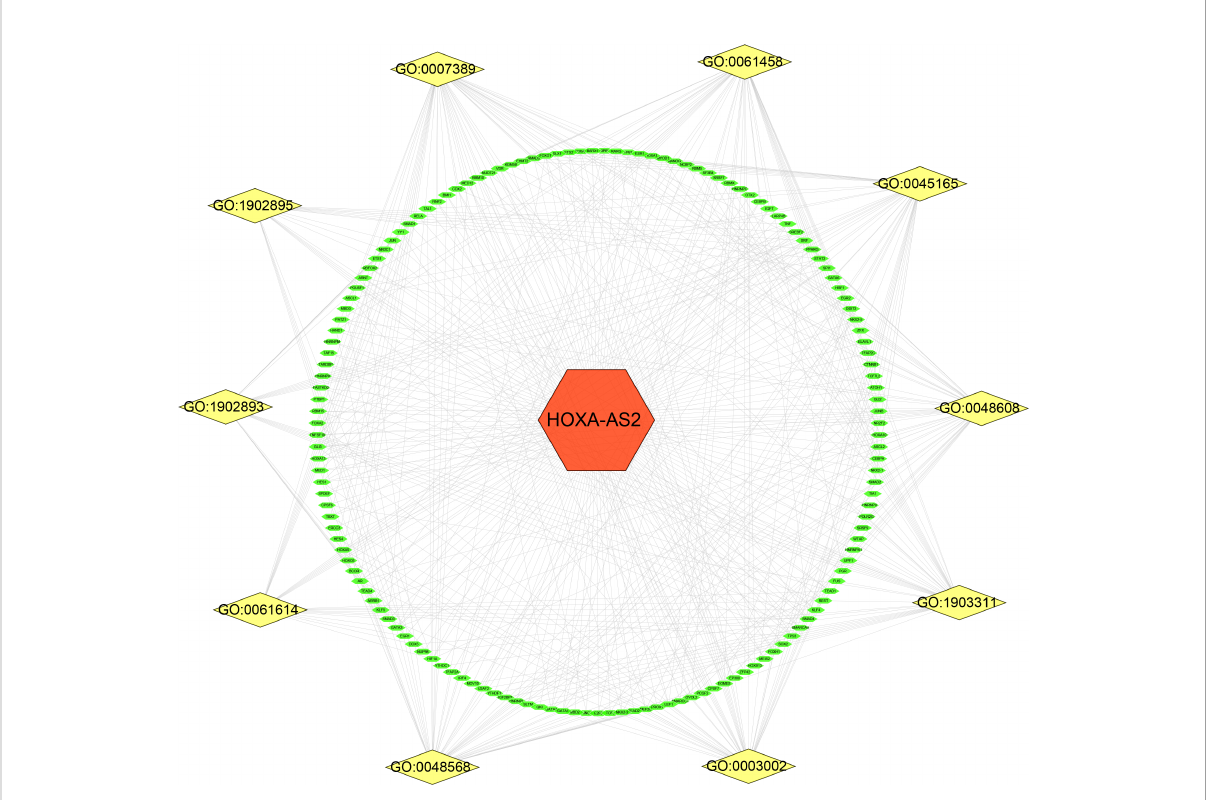
FIGURE 6 Related gene interaction network analysis. Yellow nodes represent the related pathway and green nodes represent target genes. GO:0061614 (pri-miRNA transcription by RNA polymerase II); GO:1902893 (regulation of pri-miRNA transcription by RNA polymerase II); GO:0045165 (cell fate commitment); GO:1902895 (positive regulation of pri-miRNA transcription by RNA polymerase II); GO:0007389 (pattern speci fi cation process); GO:1903311 (regulation of mRNA metabolic process); GO:0003002 (regionalization); GO:0048568 (embryonic organ development); GO:0048608 (reproductive structure development); GO:0061458 (reproductive system